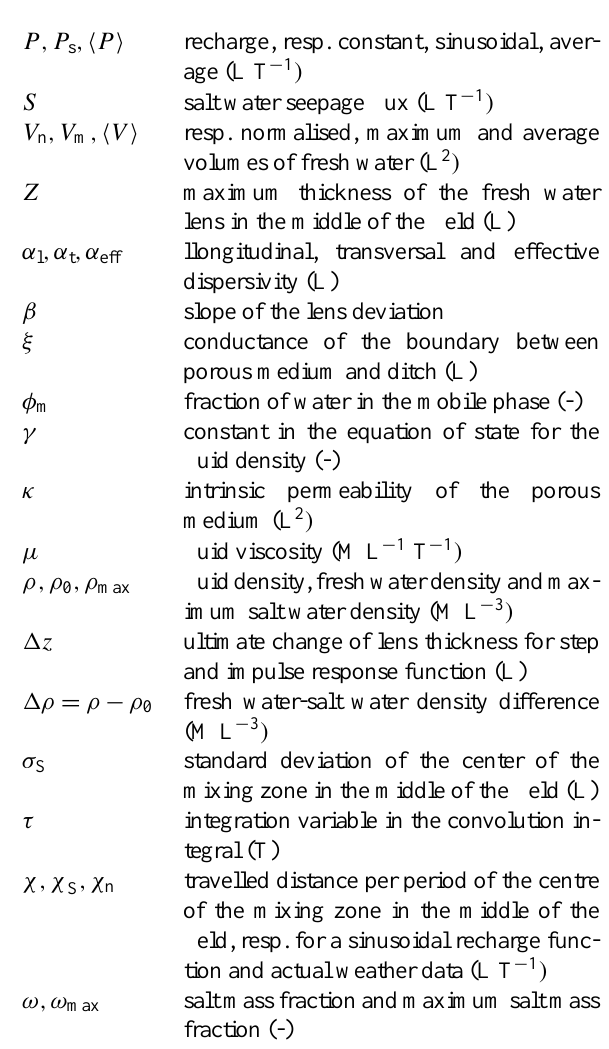
lens of 5m thick (their Fig. 5a). A positive change means a thicker